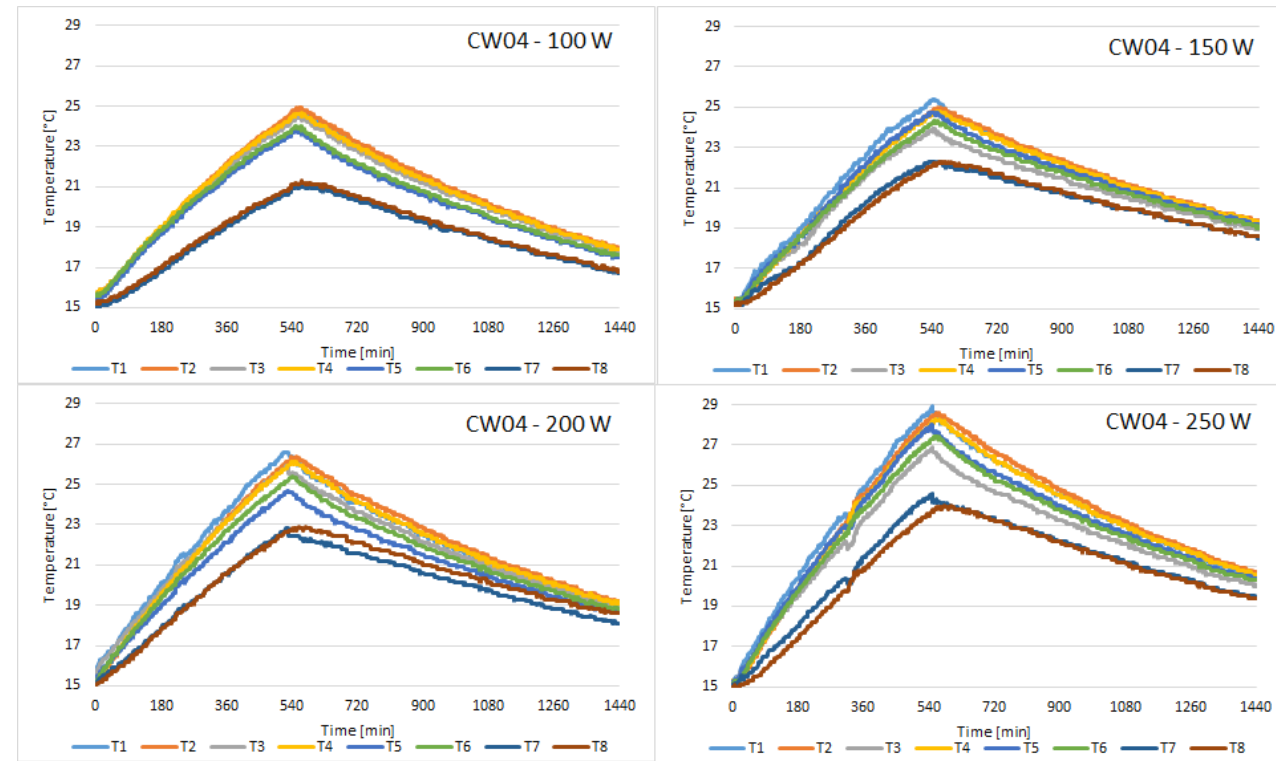
Figure 7. Temperature variation recorded by the sensors for concrete sample CW04. With the temperature values recorded by the sensor, the conductive heat transfer was calculated at the end of the charging cycle and at the end of the discharging cycle using Equation (1), constituting the heat gain of the wall.